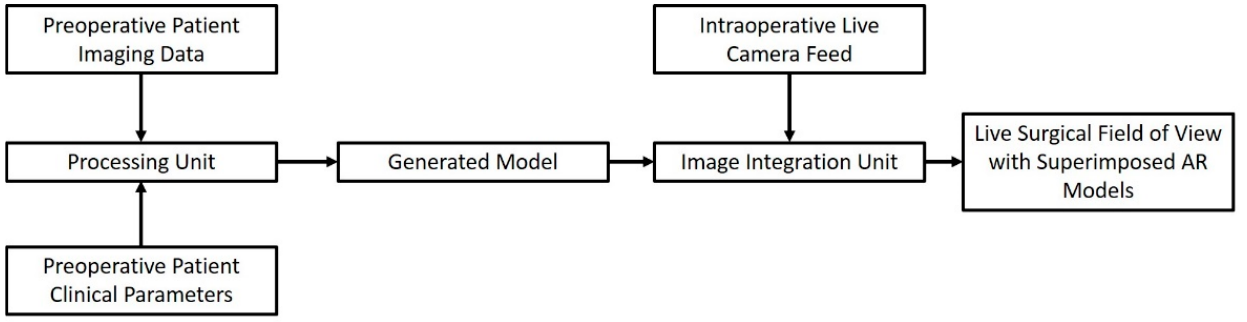
Figure 2. Connected IoST entities and workflow of an IoST-based Image-Guided Surgical System . Current literature in IGS is heavily referred to as advances in the neurosurgical field.